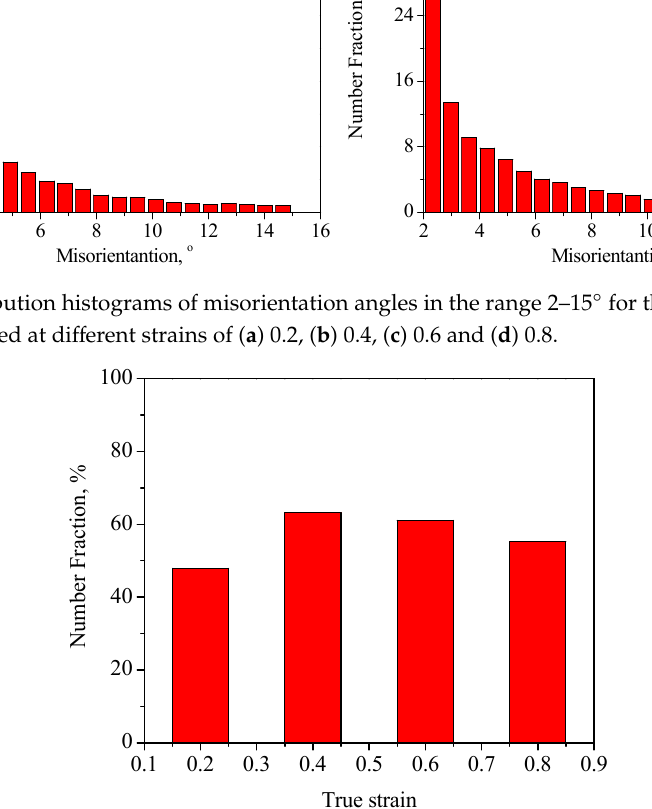
Table 2. The values of ε p and ε c at di ff erent deformation